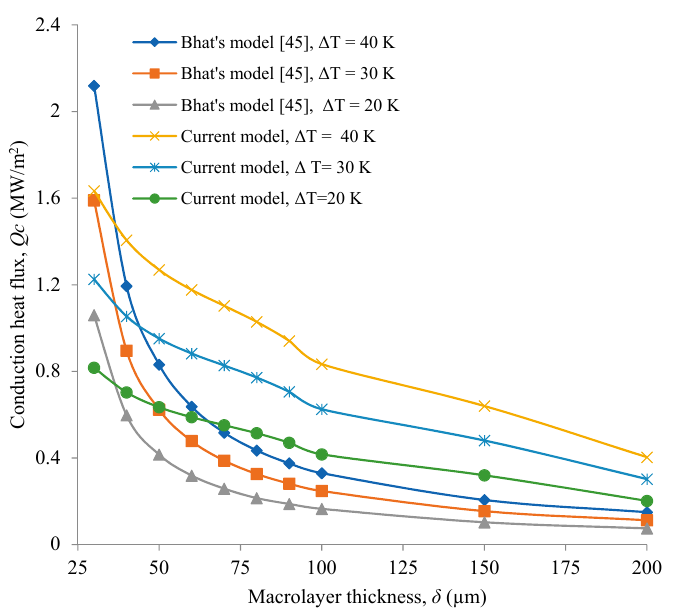
Figure 2. Prediction of heat fluxes with macrolayer thickness using current model.